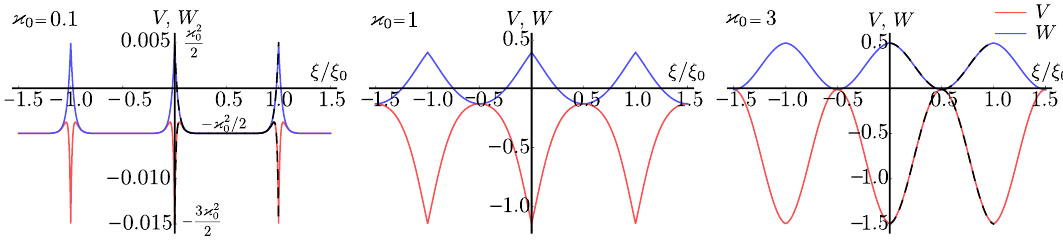
Figure 5: Magnon potentials (A.8) are shown by solid lines for different (cid:99) lines correspond to asymptotes (B.13) and (B.16) for (cid:99)